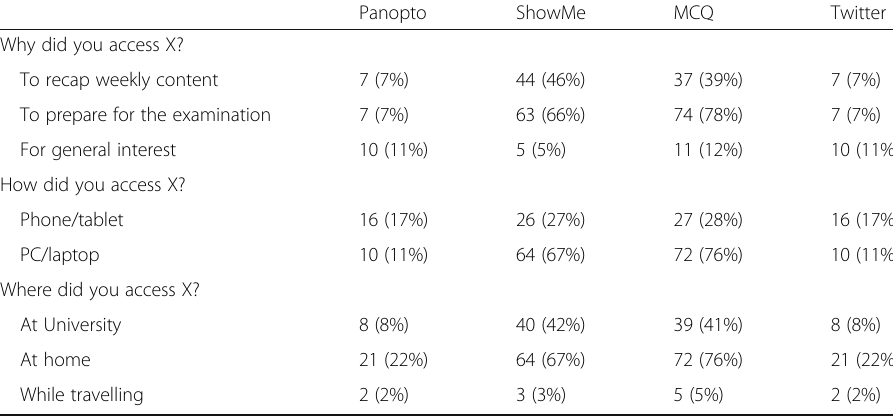
Table 3 A summary of student access to the TELTs